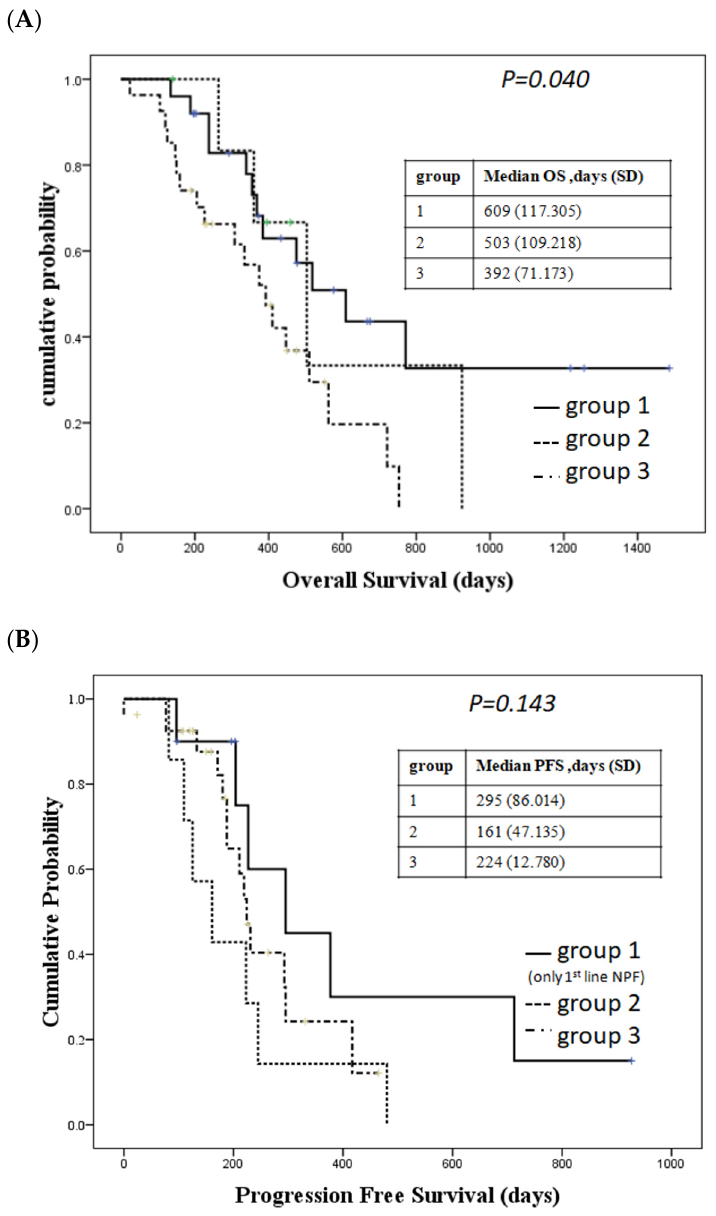
Figure 1. Survival in different treatment groups. ( A ) Overall survival (OS) in different groups. Group 1: patients received nivolumab + chemotherapy; Group 2: patients received nivolumab + ipilimumab; Group 3: patients received chemotherapy with PF as first-line therapy. ( B ) Progression-free survival (PFS). Group 1: patients received nivolumab + chemotherapy as first-line therapy; Group 2: patients received nivolumab + ipilimumab; Group 3: patients received chemotherapy with PF as first ‐ line therapy.